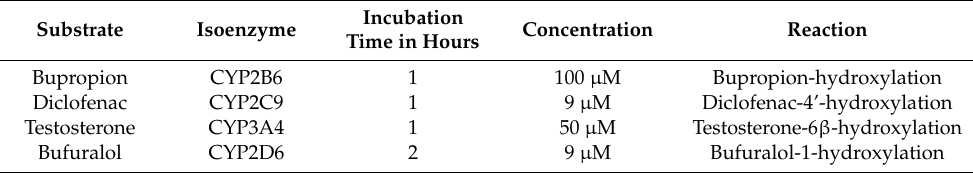
Table4. Substrates, concentrations,